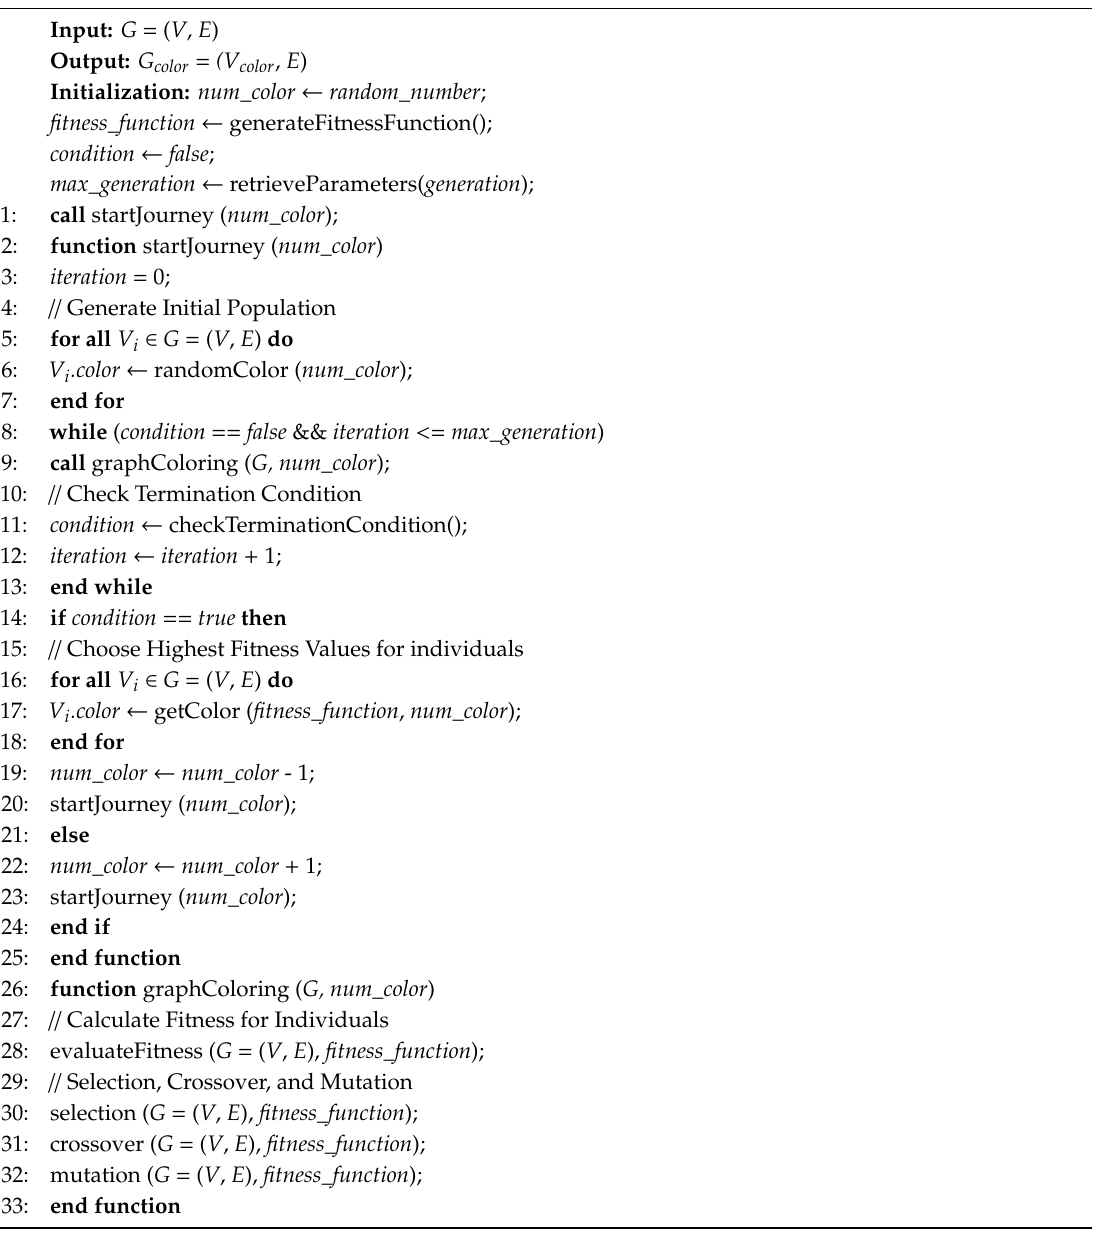
Algorithm 1. The proposed load balancing algorithm based on graph